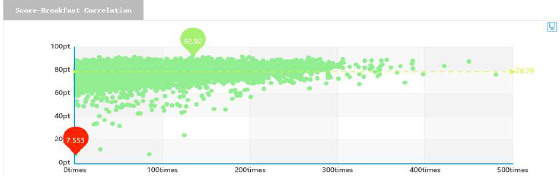
Figure 2. Breakfast frequency-score Correlation analysis of students' breakfast frequency and test scores (Figure 2);